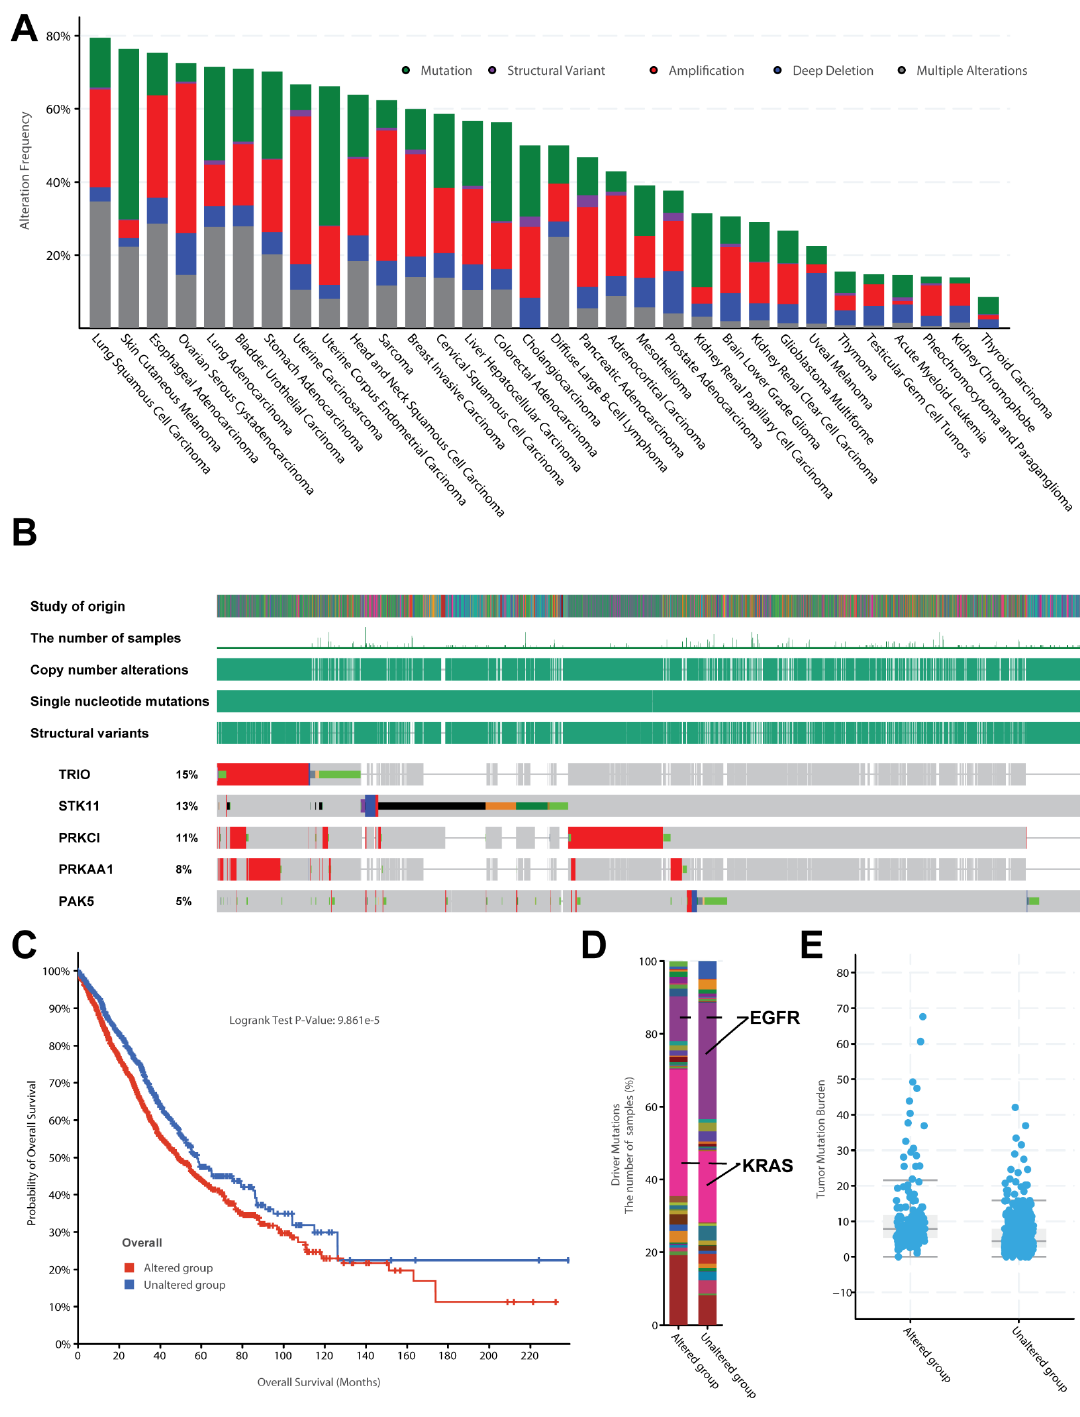
Figure 7. Clinical features for the top 50 cancer proteins interacting with seaweed proteins based on the TCGA cancer genomics data. ( A ) Mutational frequency among the 32 TCGA pan-cancer datasets. ( B ) The sample-based oncoprint for the top five genes mutated in thousands of lung cancer cohorts across 24 independent genomic studies. ( C ) Survival curve for the top 50 genes in thousands of lung cancer cohorts across 24 independent lung cancer genomic studies. ( D ) Driver mutations of the samples with and without mutations on the top 50 genes; KRAS mutations are in pink, while EGFR mutations are marked in purple. ( E ) Mutation burden of patient groups with and without mutations on the top 50